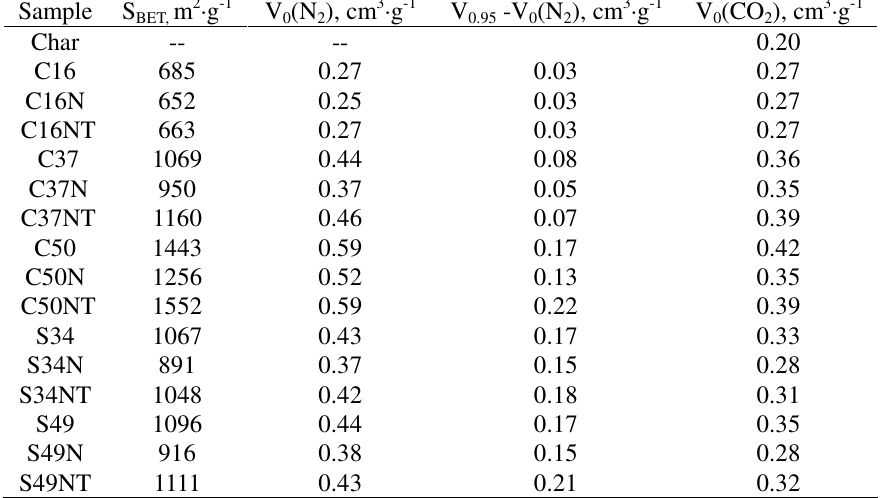
and CO adsorption 2 2